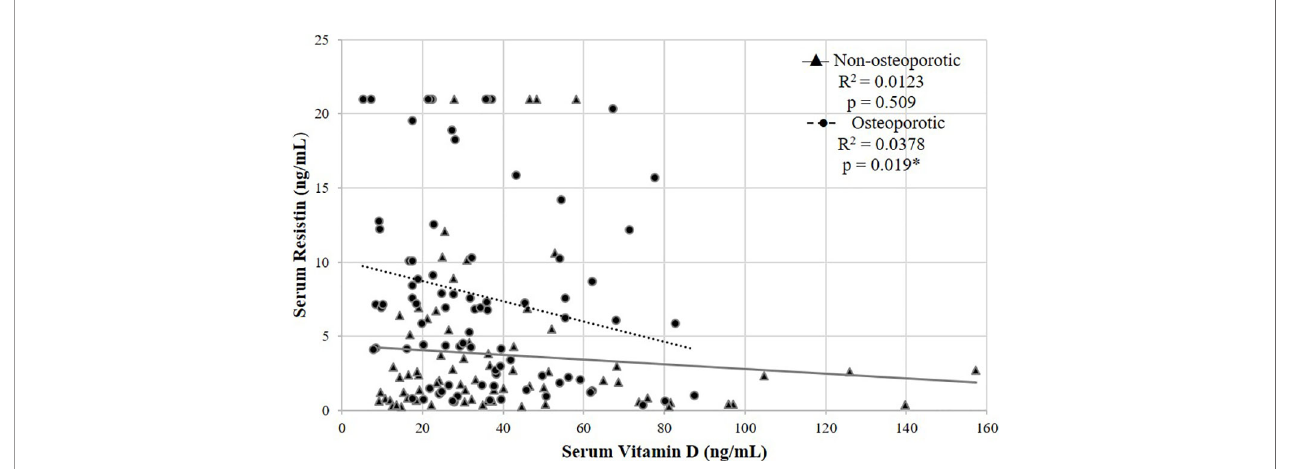
FIGURE 2 | Scatter plot showing a negative correlation between serum resistin and vitamin D in postmenopausal non-osteoporotic and osteoporotic females using spearman ’ s rho correlation coef fi cient. *p < 0.05 is statistically signi fi